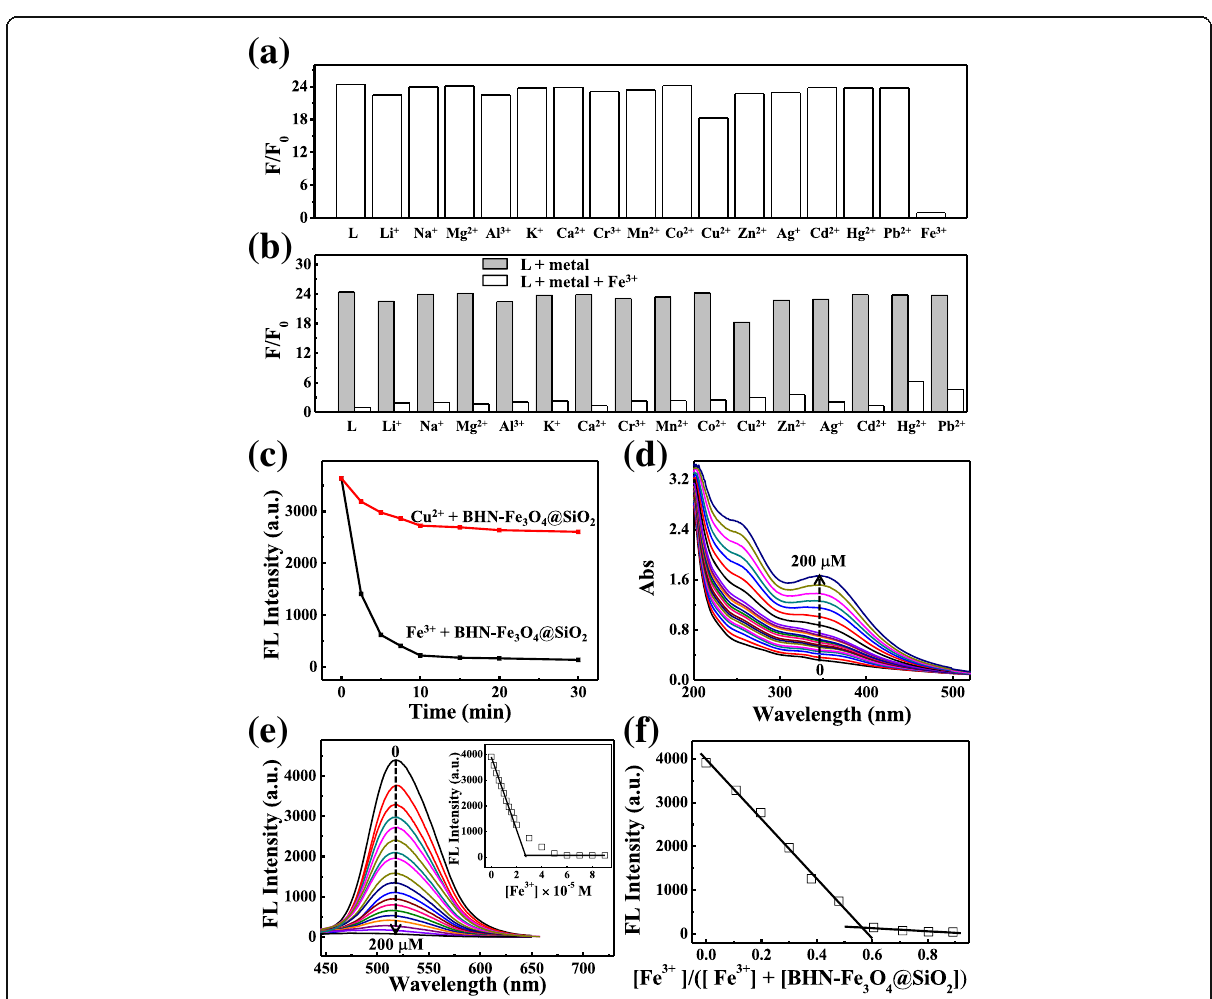
Fig. 3 a Fluorescence responses of BHN-Fe 3 O 4 @SiO 2 with various cations. Excitation wavelength was 415 nm. Spectra were recorded every 2 min after adding metal ions. b Competition of Fe 3+ -BHN-Fe 3 O 4 @SiO 2 towards cations. Fluorescent emission change of BHN-Fe 3 O 4 @SiO 2 (0.2 g/L) upon addition of metal ions (each metal ion is 5 × 10 − 5 M) in CH 3 CN/H 2 O 1:1 (HEPES buffer pH 7.36) at room temperature. c Time responses of BHN- Fe 3 O 4 @SiO 2 with Fe 3+ and Cu 2+ . d UV-Vis titrations of BHN-Fe 3 O 4 @SiO 2 (0.2 g/L) with Fe 3+ . e Fluorescence titration of BHN-Fe 3 O 4 @SiO 2 (0.2 g/L) with Fe 3+ . Inset: the fluorescence intensities at 518 nm at various concentrations of Fe 3+ . f Job ’ s plot of BHN-Fe 3 O 4 @SiO 2 with Fe